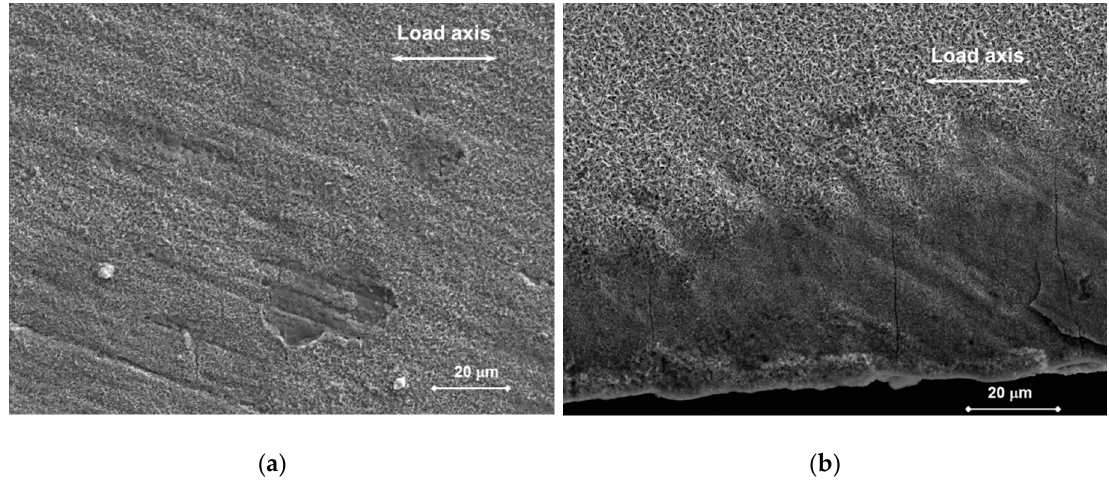
Figure 9. T38 (R2) in Pb, chemical cleaning: ( a ) ground and ( b ) polished surfaces in the minimum cross